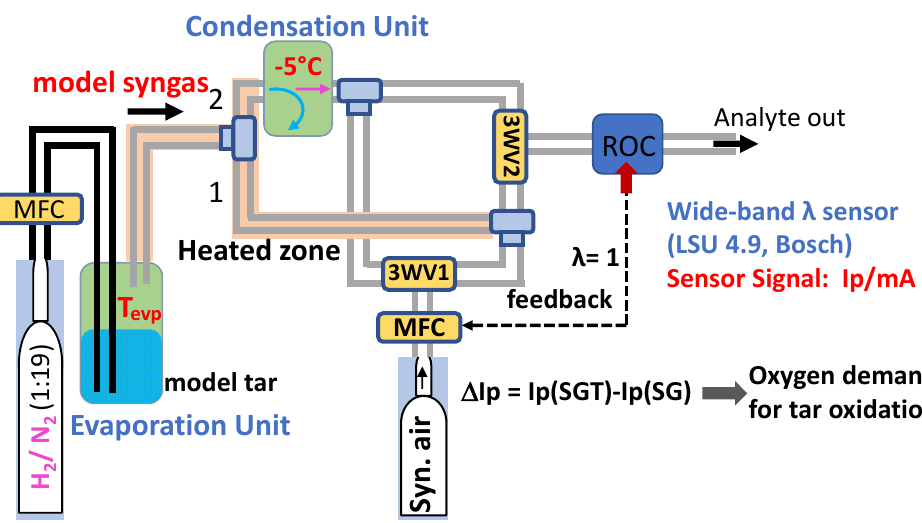
Figure 2. Laboratory experimental setup for the evaluation of the tar monitoring concept. A constant N 2 /H 2 (19:1) gas flow and synthetic air dosage were achieved by electronic mass flow controllers (MFCs). The two pathways (1/2) of the syngas (without/with tar condensation) were set by the 3-way valve 3WV2. Furthermore, 3WV1 enables the alternative dosage of equal synthetic air streams in both pathways.